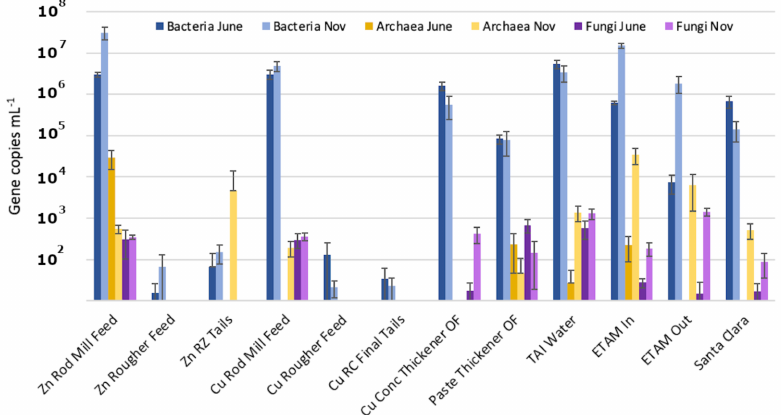
Figure 5. The average numbers of bacterial and archaeal 16S rRNA gene copies mL − 1 , and fungal 5.8S rRNA gene copies mL − 1 in the June and November samplings. Each bar is the average of three parallel qPCR reactions of three replicate samples and the error bars display standard deviation. The y-axis displays number of gene copies mL − 1